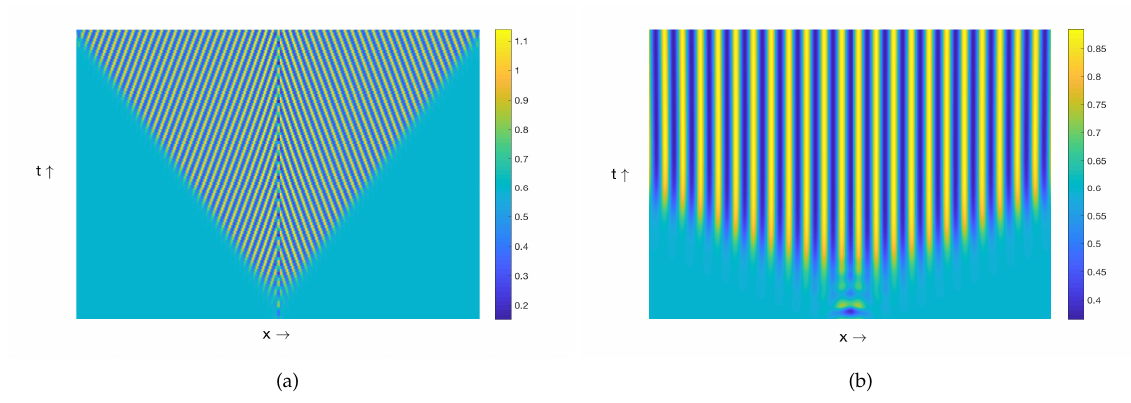
Figure 3. ( a ) Resulting spatio-temporal patterns produced by the nonlocal model (13)–(14) for d 2 = 0.3, M = 6.5 and other parameter values as mentioned in the text. ( b ) Stationary pattern produced by the prey population for d 1 = 1, d 2 = 1 and M = 6, other parameters are mentioned at